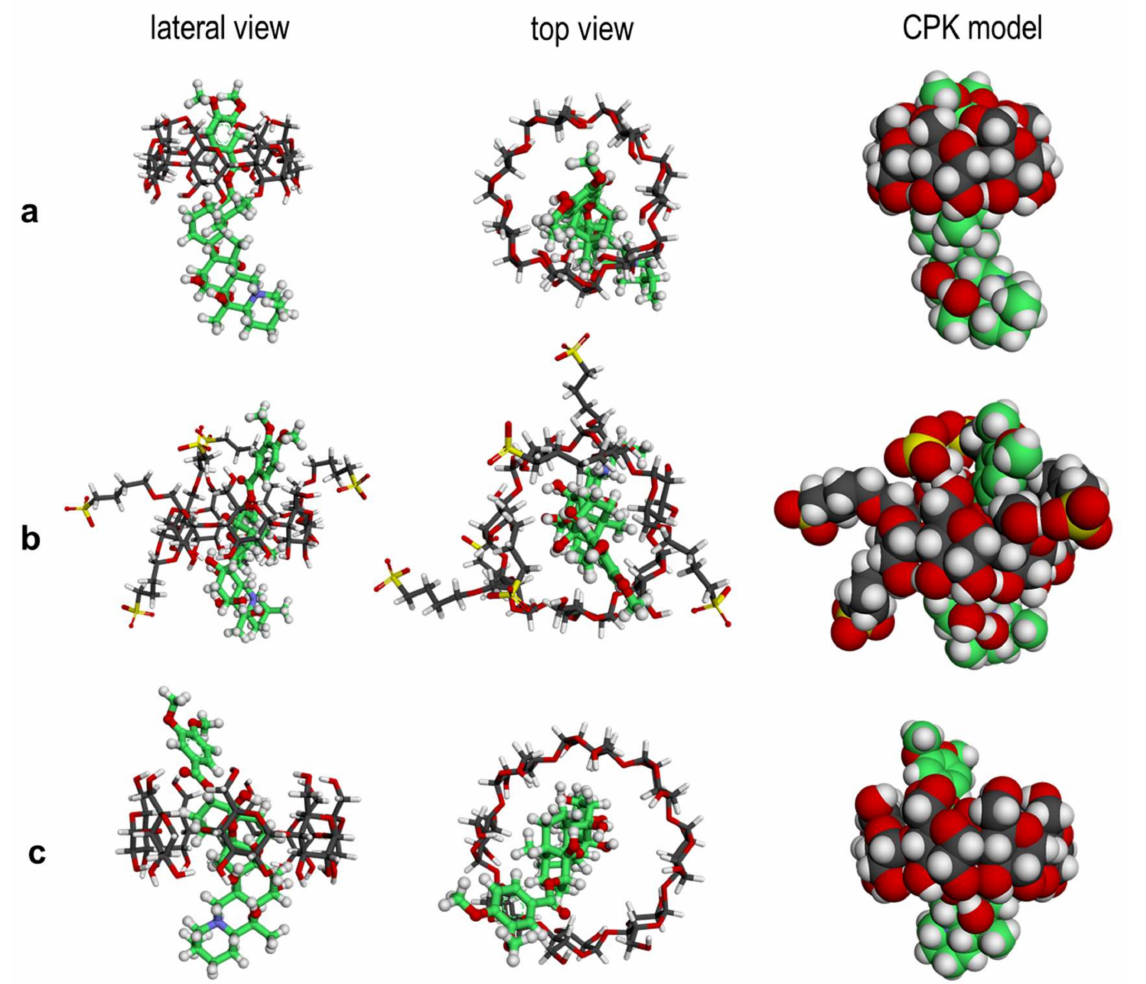
Figure 7. Three-dimensional energy-minimized structures obtained by molecular docking of the inclusion complex between VTD and ( a ) β -CD, ( b ) SBCD, and ( c ) γ -CD. The C atoms of VTD have been highlighted in